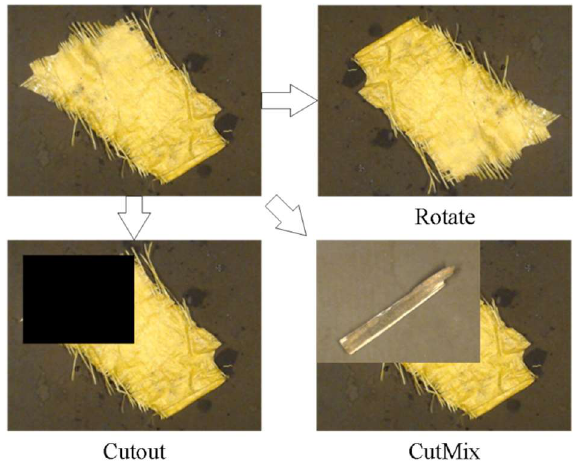
Figure 14. Traditional augmentation method.